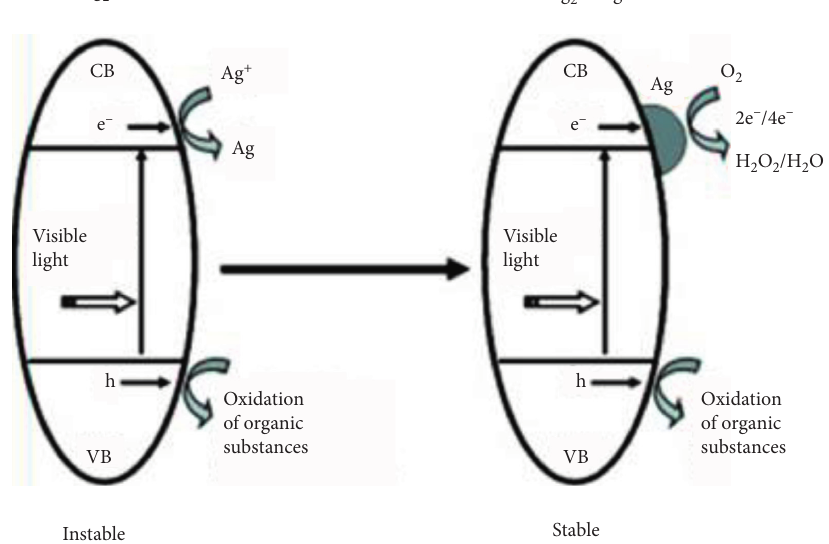
Figure 11: Schematic diagrams showing the self-stabilizing process of Ag 2 O photocatalyst under visible light irradiation: (left) photo- generated electrons are captured by Ag + ions on the as-prepared Ag 2 O; (right) photogenerated electrons are captured by O 2 through metallic Ag, which is formed during the initial light irradiation of fresh Ag 2 O (h + � holes and e − � electrons)